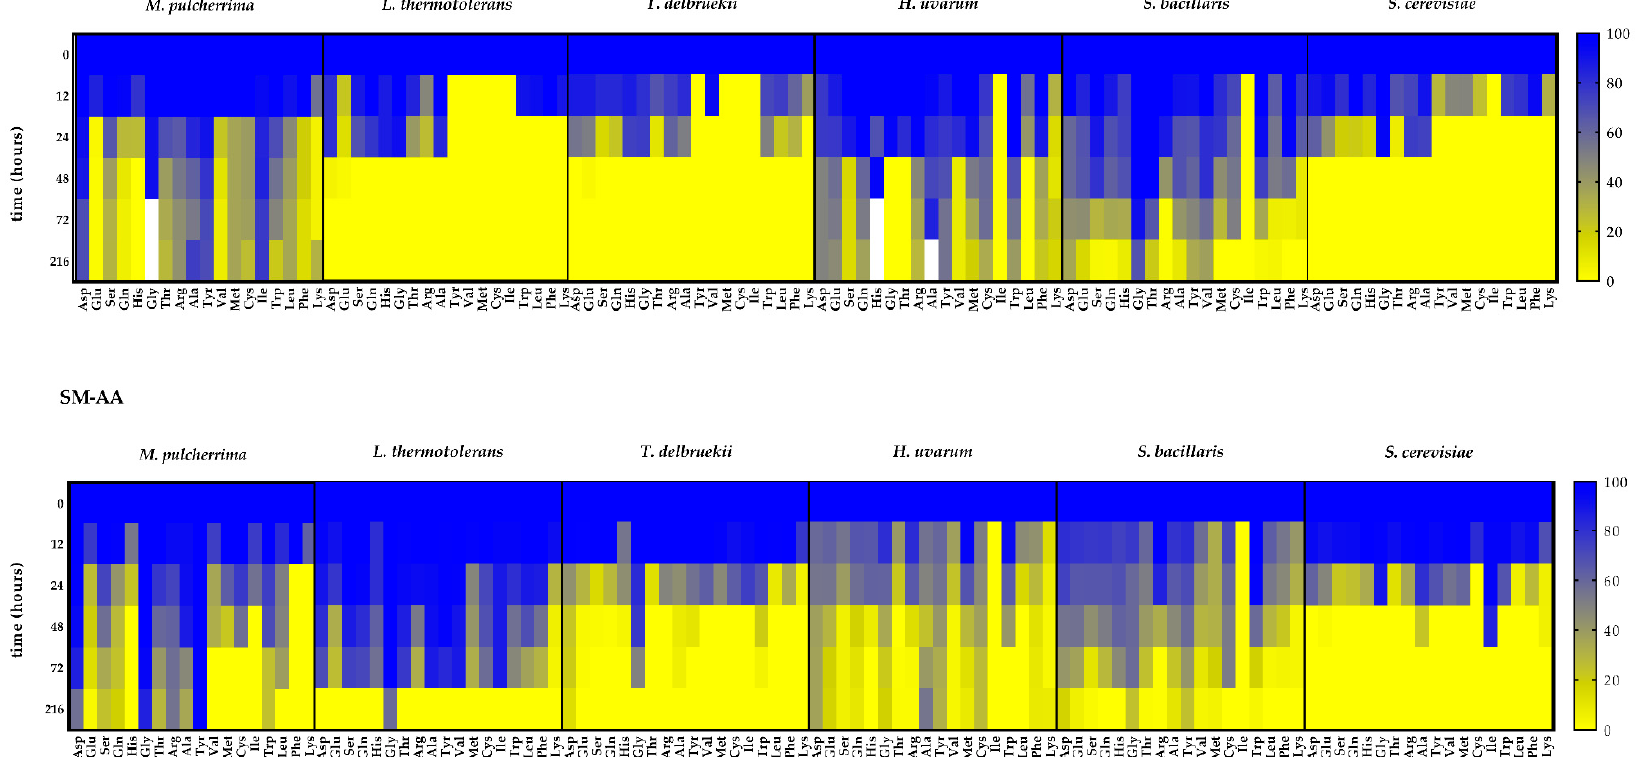
Figure 5. Amino acid concentration (%) present in the medium at di ff erent time points of the alcoholic fermentation in SM-Mix and SM-AA. The initial concentration of each amino acid is expressed as 100%. White color represents more than 100%.